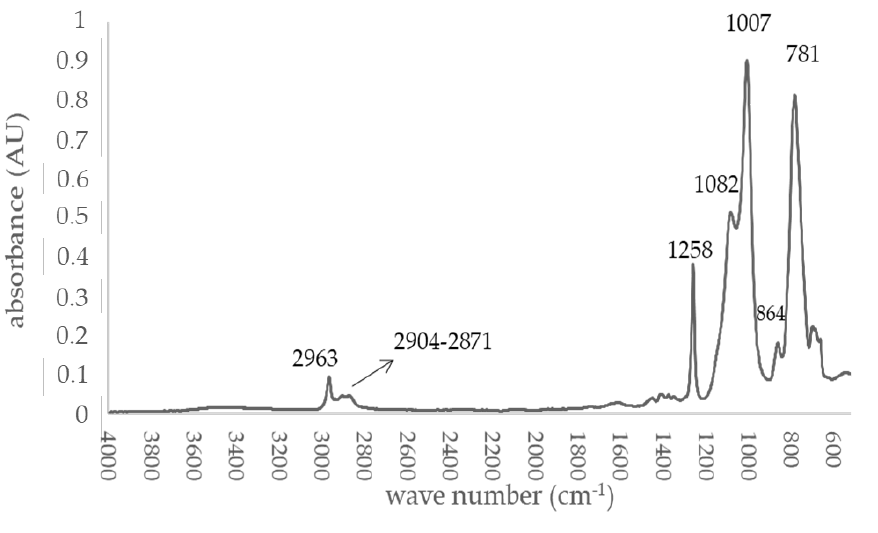
Figure 5. FTIR spectra of SL-2.